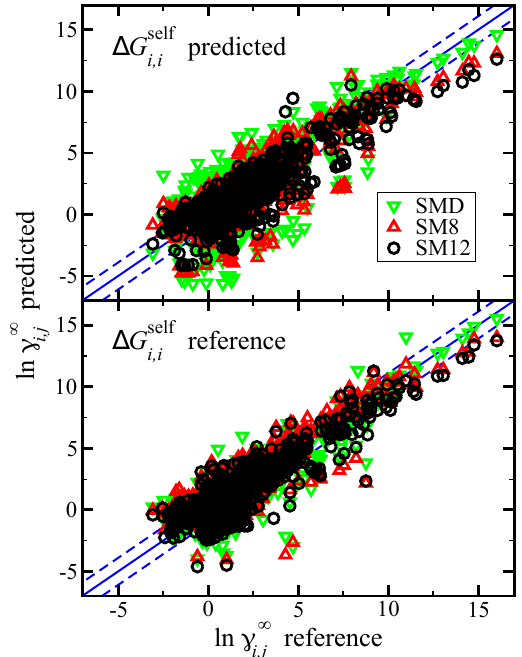
Figure 4. Parity plot of the predicted versus reference values of ln γ ∞ Database version 2012 [47]. Predictions are made using the SM12, SM8, and SMD universal solvent model, as indicated. The blue lines corresponds to the y = x line, and the dashed blue lines correspond to ± 1.1 and are drawn as a reference; the value of 1.1 was used based on the RMSE for the SM12 predictions. In the top pane we present results when ∆ G self or SMD universal solvent model. In the bottom pane we present results when ∆ G self using reference vapor pressure